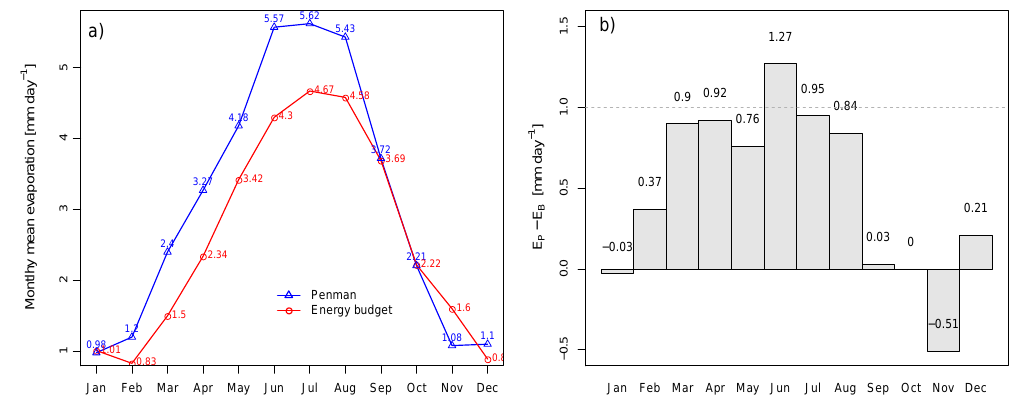
Figure 8. a) Monthly mean evaporation. b) Monthly mean difference between Penman, E P , and BREB evaporation, E B .